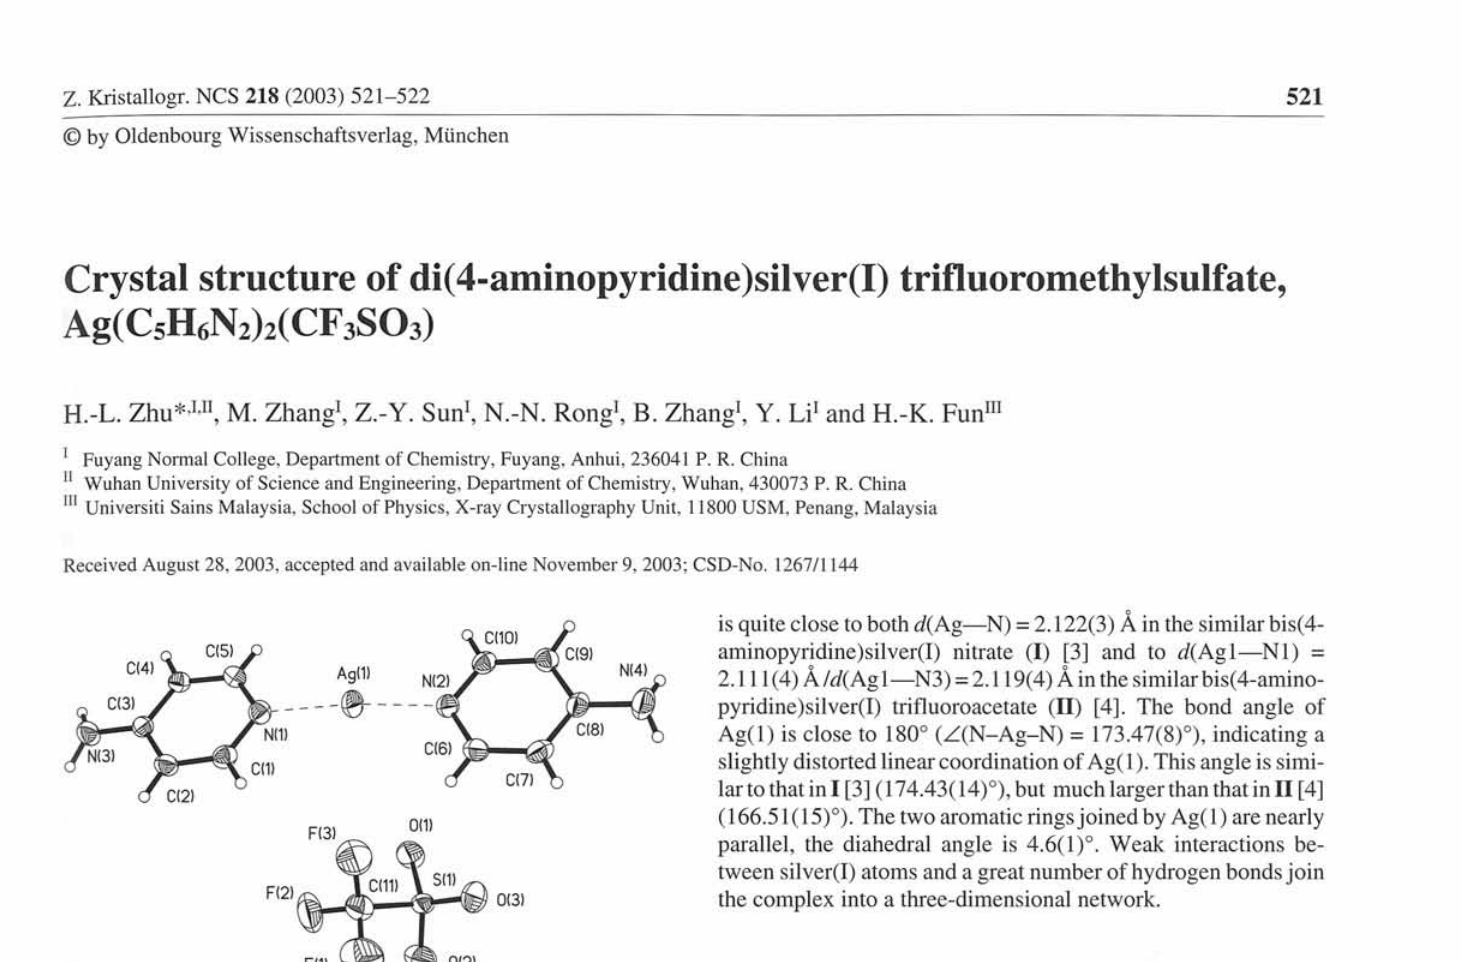
Table 1. Data collection and handling.